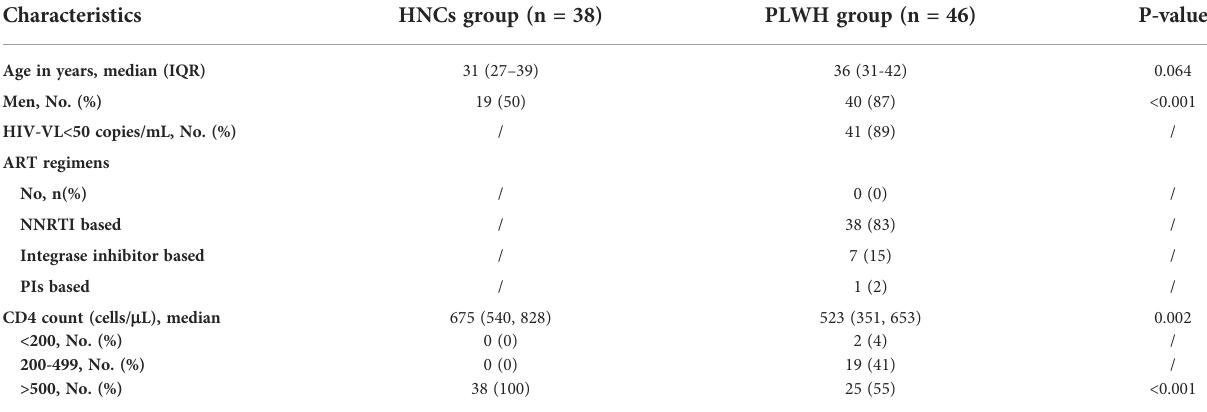
TABLE 1 Baseline characteristics of the study participants in Wuhan, China (N = 84), 2021.